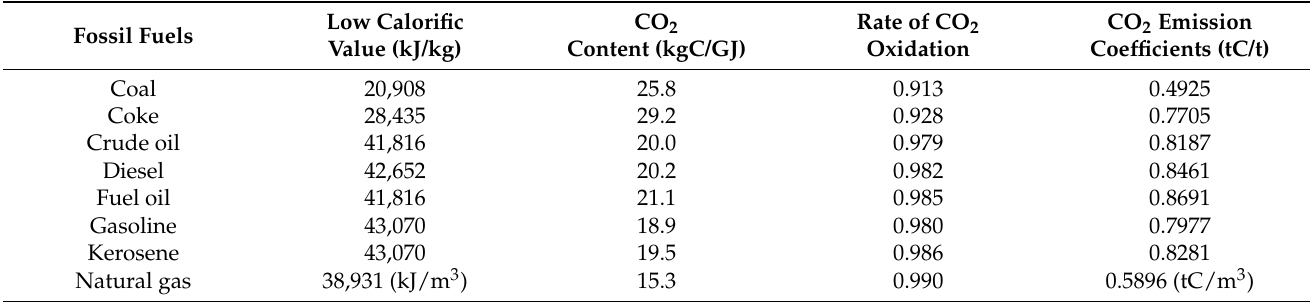
Table 1. CO 2 emission coefficients of various fossil